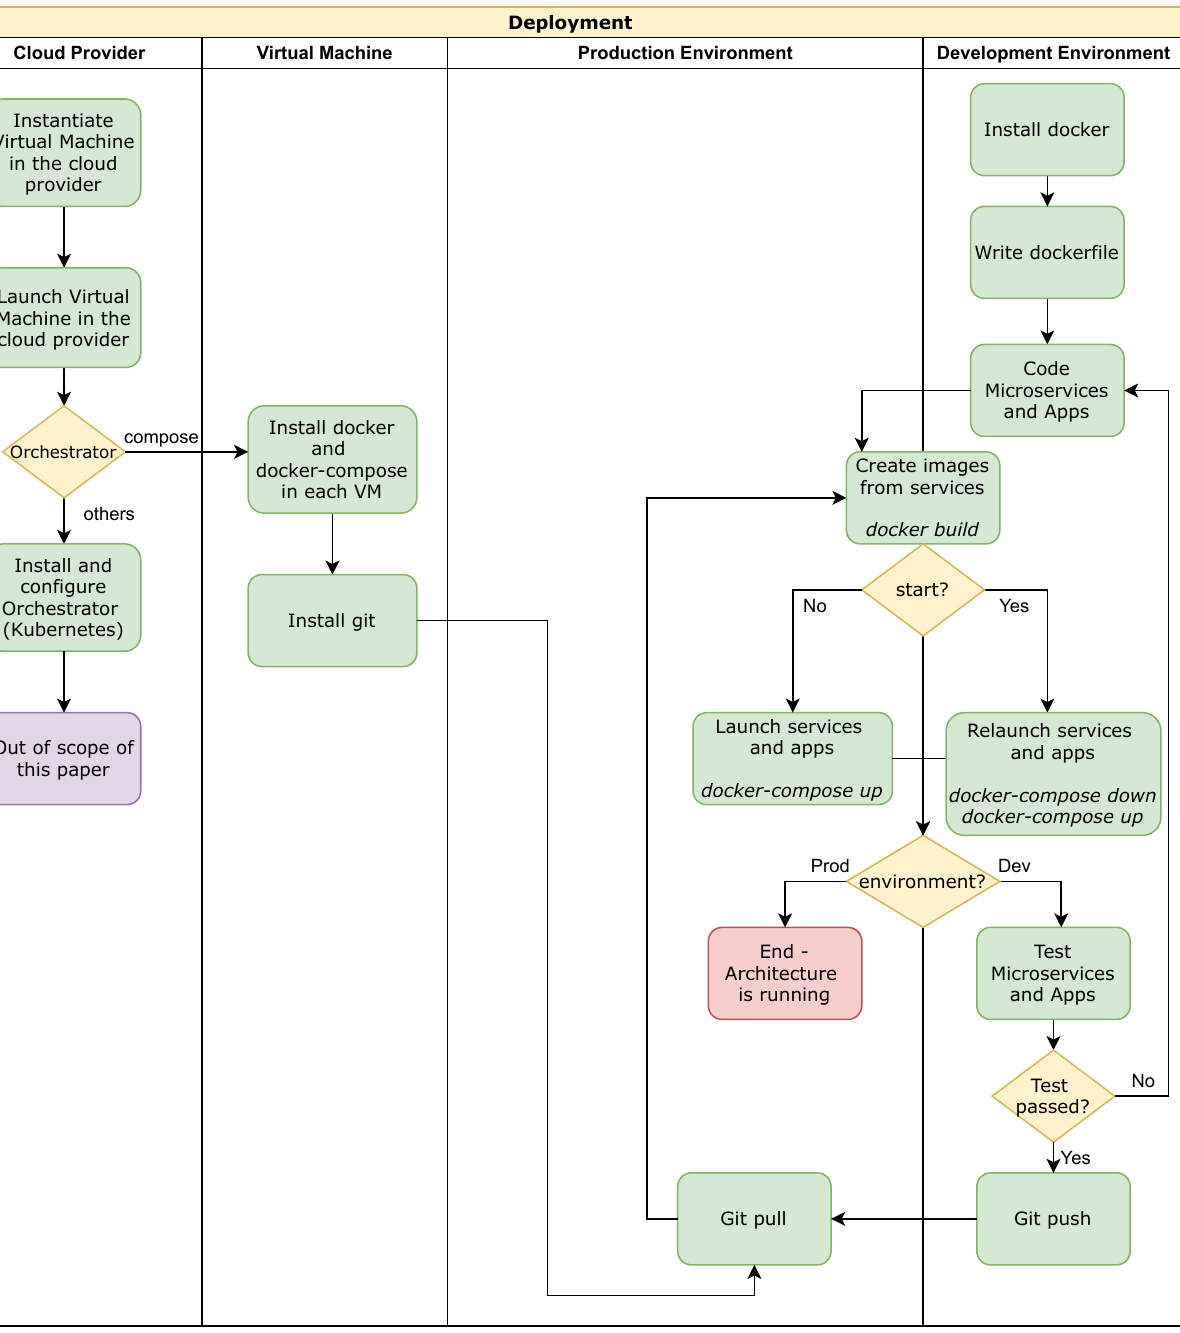
Figure 3. Block diagram of the deployment of the architecture.